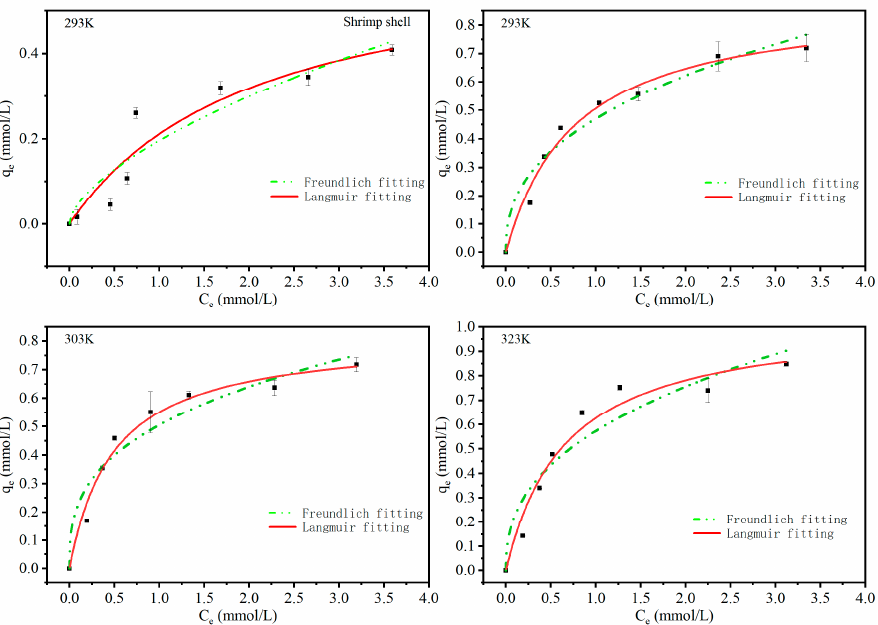
Figure 4. Langmuir and Freundlich fitting of adsorption isotherms for Cu (II) on shrimp shell at 293 K and MS at 293 K, 302 K and 323 K.